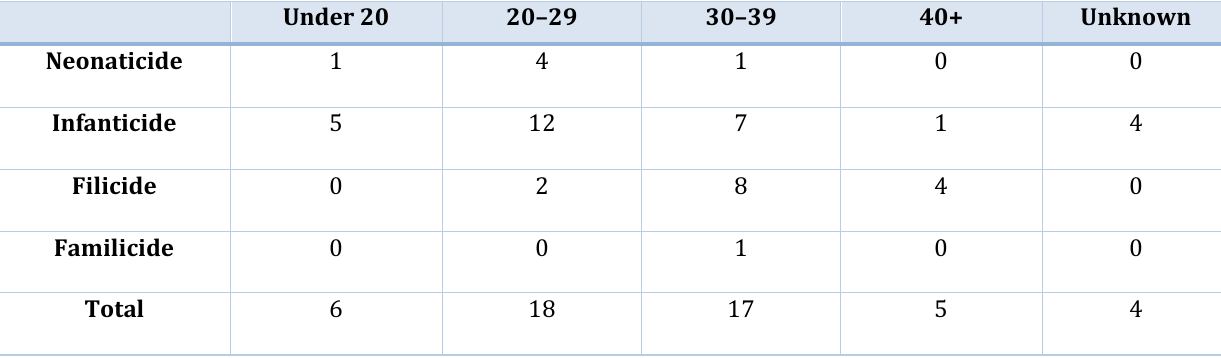
Table 3: Number of Offenders per Age Group and Filicide Type, Victoria, 1860 –